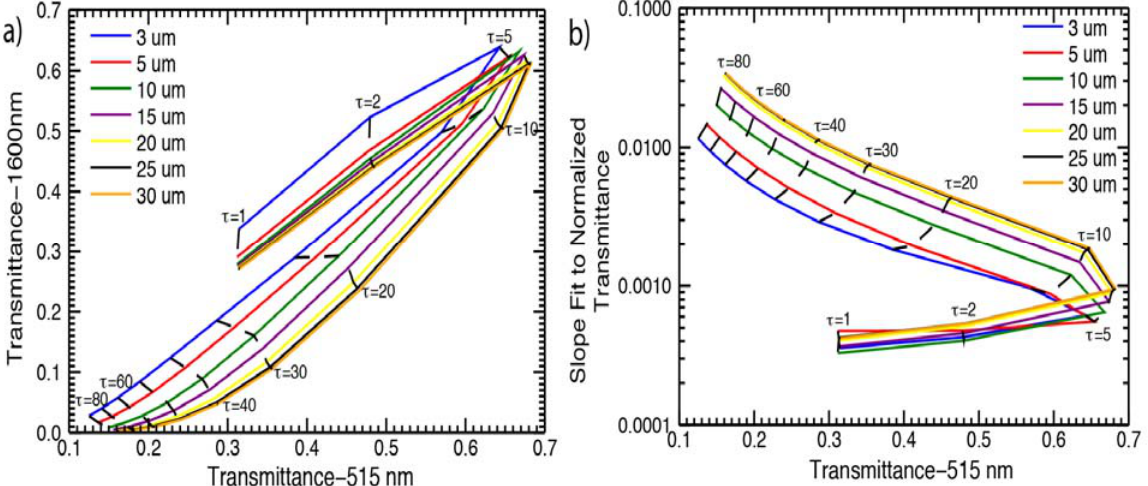
= 0.75 and a vegetated surface 0